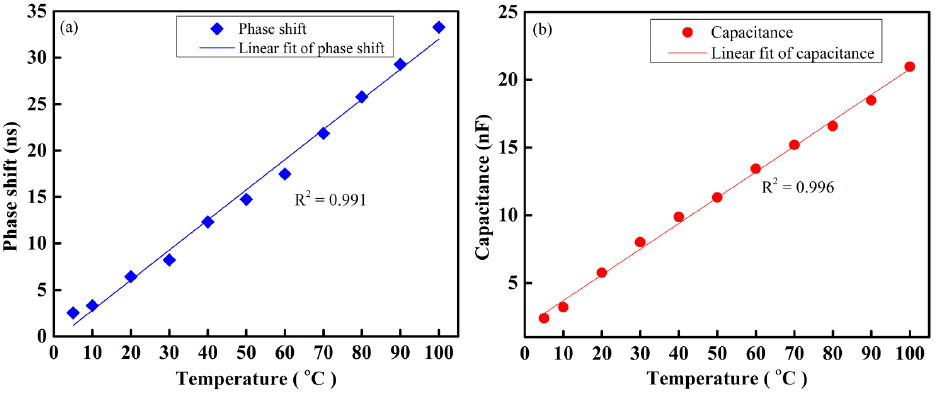
Figure 9. Behavior of the proposed IDC thermal/temperature sensing system under different temperatures: ( a ) Phase shift and ( b ) Capacitance.